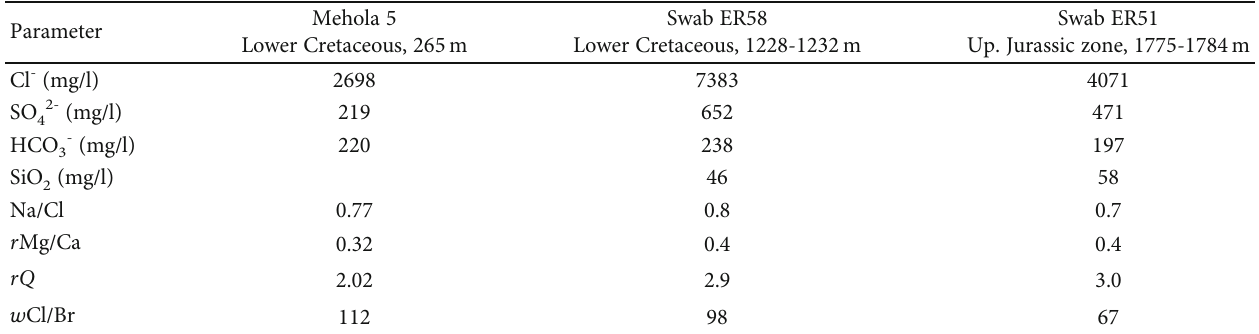
Table 4: Comparison of chemical compositions from the Upper Jurassic to Lower Cretaceous beds with groundwater from the adjacent Mehola 5 borehole.